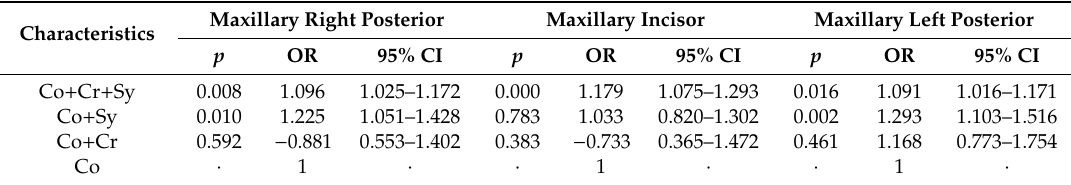
Table 3. CPI of Maxillary by Region and Co ff ee Component.